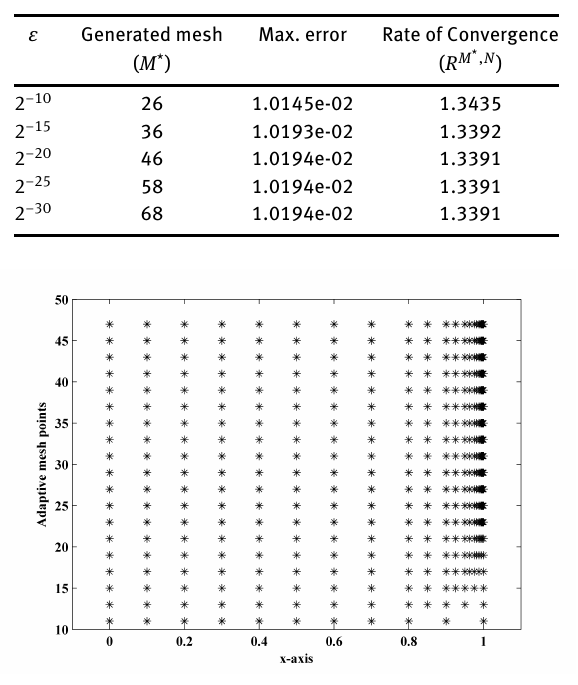
Table 4: Maximum point wise errors of the solution and correspond- ing rate of convergence for Example 5.2 by taking δ = 0.7 , η = 0 , M=10 and N=20 for different values of ε .